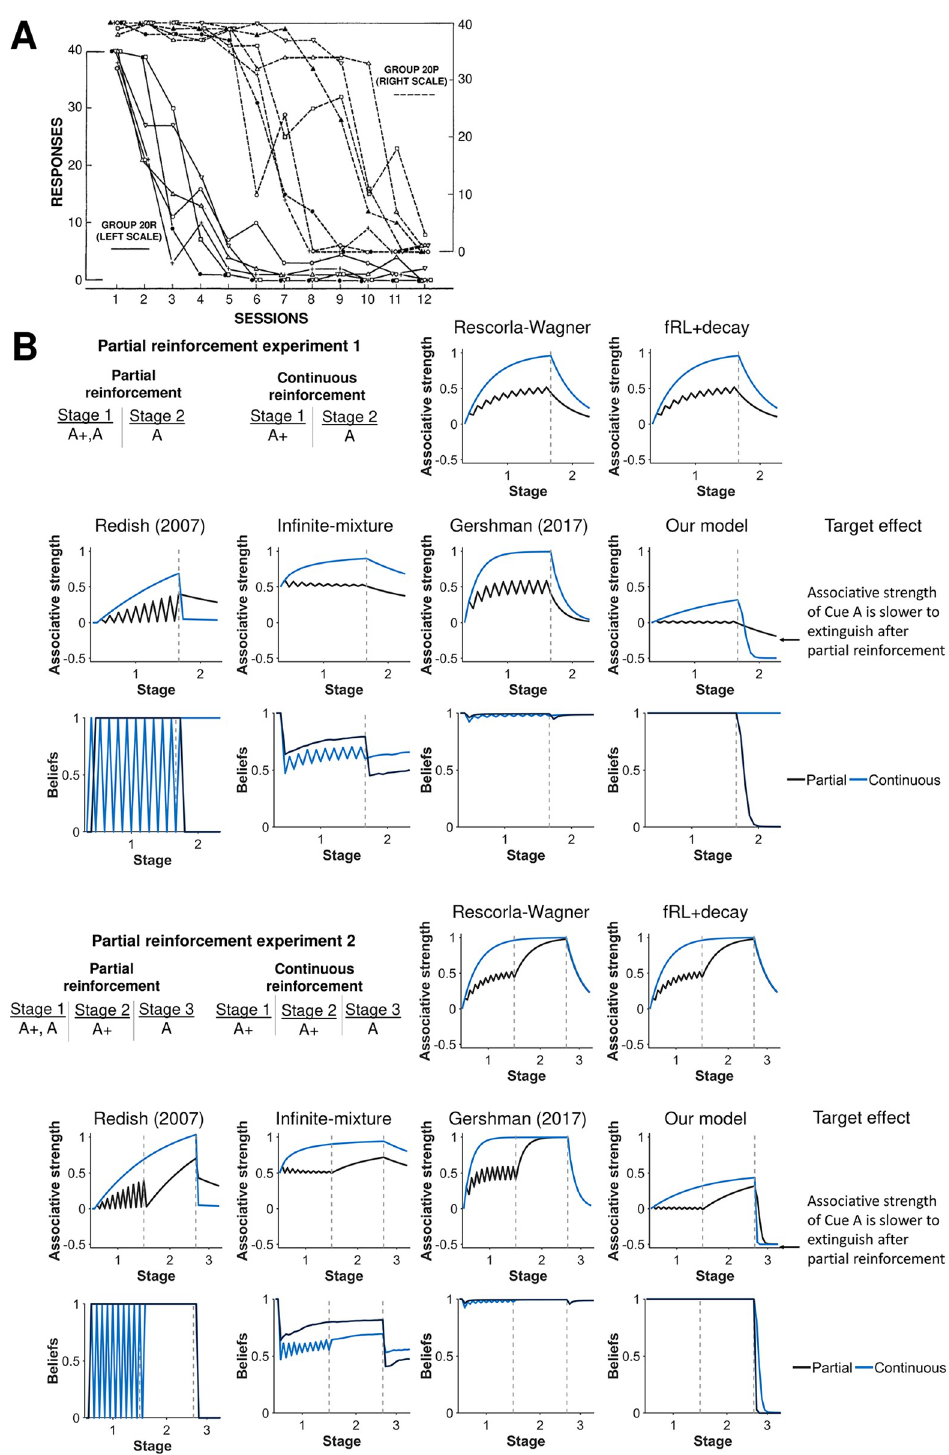
Fig 5. Partial reinforcement extinction effect. A) Experimental results from Jenkins [41] demonstrating that the associative strength of a cue is harder to extinguish after partial reinforcement (Group 20P) compared to continuous reinforcement (Group 20R). Reprinted from “Resistance to extinction when partial reinforcement is followed by regular reinforcement” by H.M. Jenkins, 1962, Journal of Experimental Psychology , 64 , p. 443. Reprinted with permission from the American Psychological Association. B ) Simulation of partial reinforcement effect